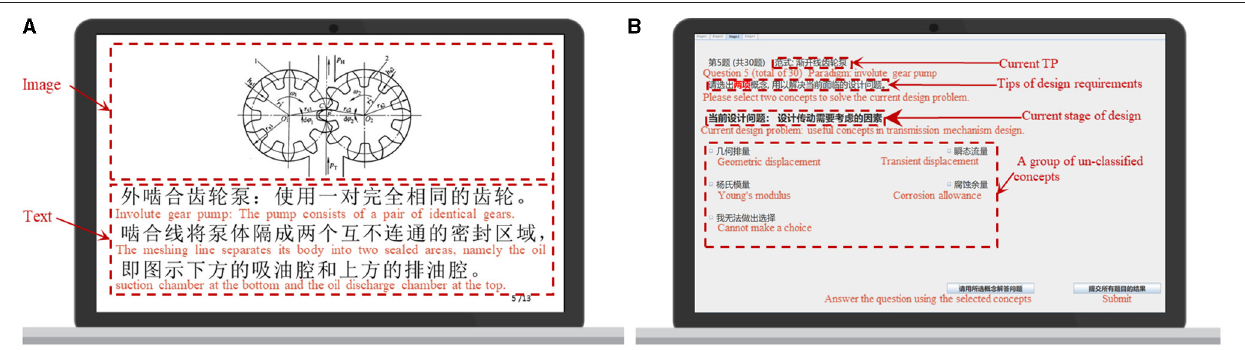
FIGURE 3 | Stimulus materials we provided for the subjects. (A) Learning tasks; (B) concept-sorting